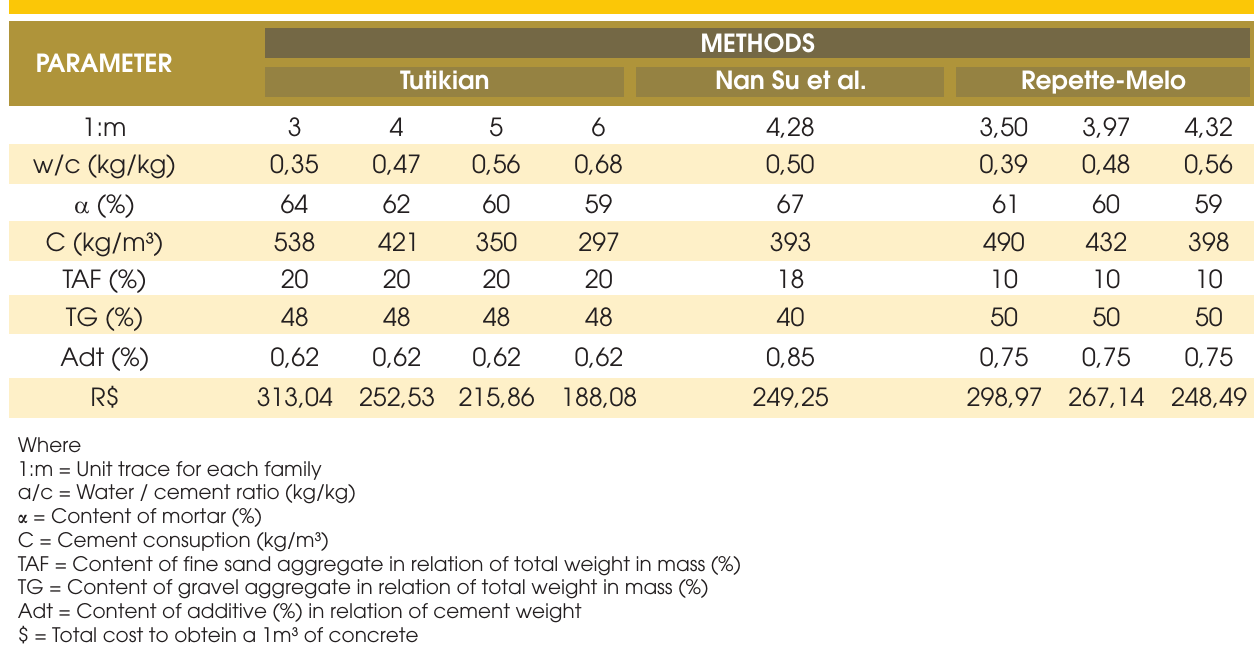
Table 1 – proportions obteined in each determination